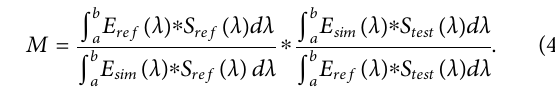
Frontiers in Energy Research |